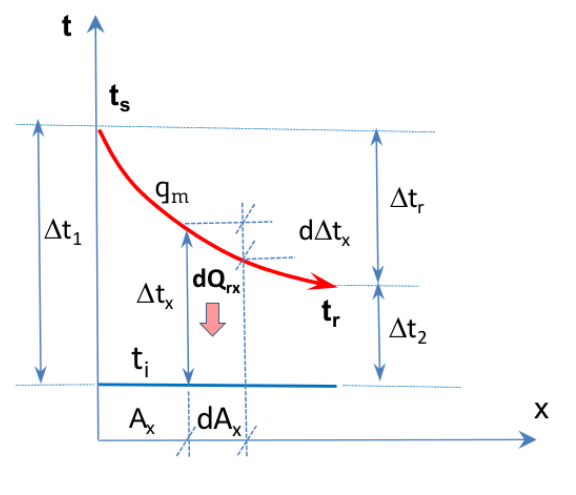
Figure 2. New heat transfer model in radiators,